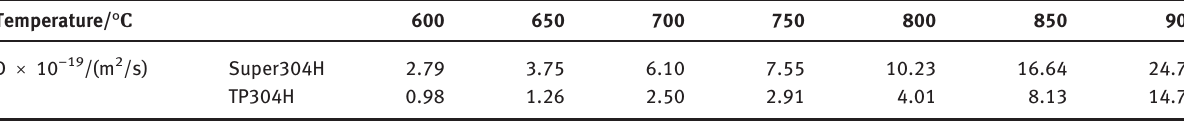
Table 3: Diffusion coefficient of Cr at different temperatures in Super304H and TP304H steels. Temperature/ ° C 